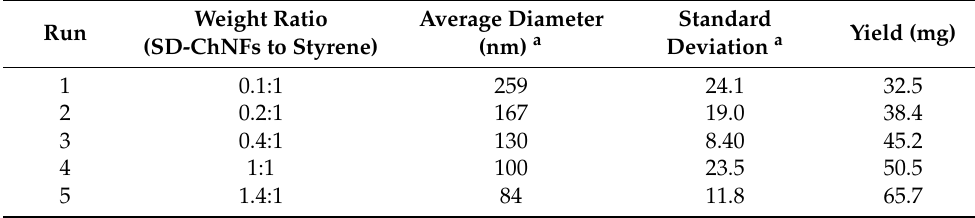
Table 1. Average diameters and yields of composite